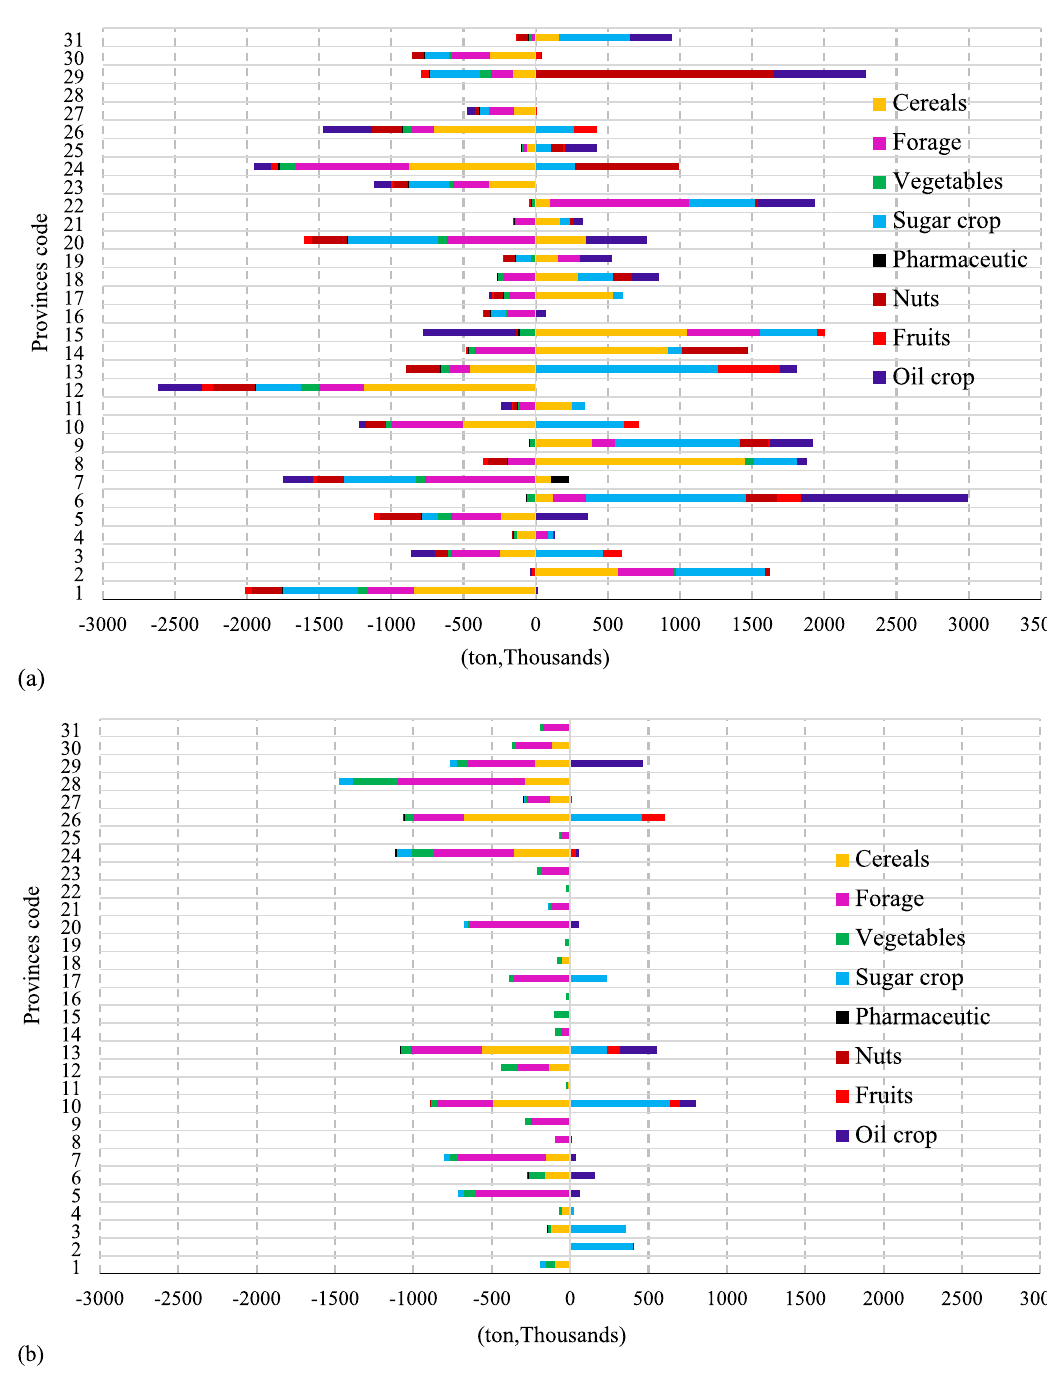
Figure 3. Deficit and surplus of crops without ( a ) and with ( b ) the trade network (ArcGIS 10.3.1